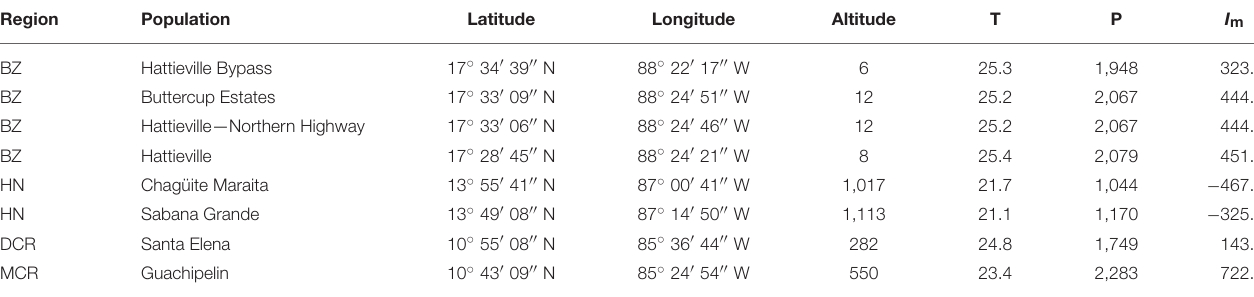
TABLE 1 | Location sites and climatic characterization of the studied populations and their belonging to climatic regions. Region Population